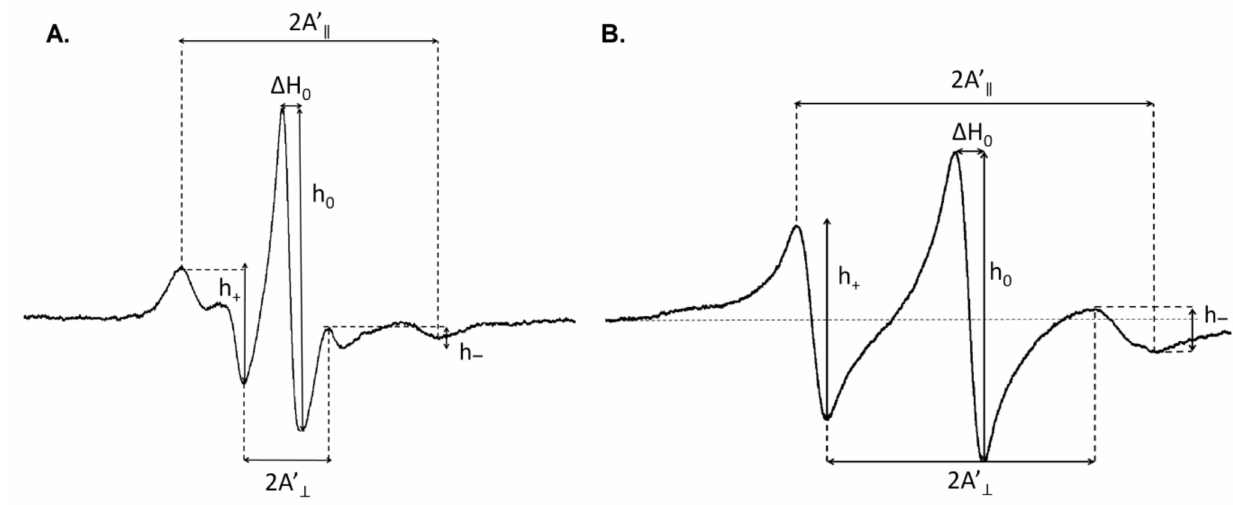
Figure 1. Schematic electron paramagnetic resonance (EPR) spectra of the SASL-5 ( A ) and SASL-16 ( B ) spin labels that had been incorporated into the chloroplast membranes. The spectral parameters that were analysed are indicated (2A’ ⊥ and 2A’ || , ∆ H 0 , and h + , h 0 and h − ).